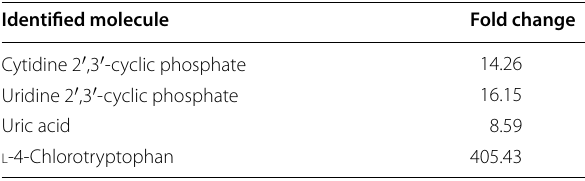
Table 2 Shortlisted extracellular metabolites showing significant fold change in micro-aerobic culture compared to aerobic culture by LC–MS analysis in negative